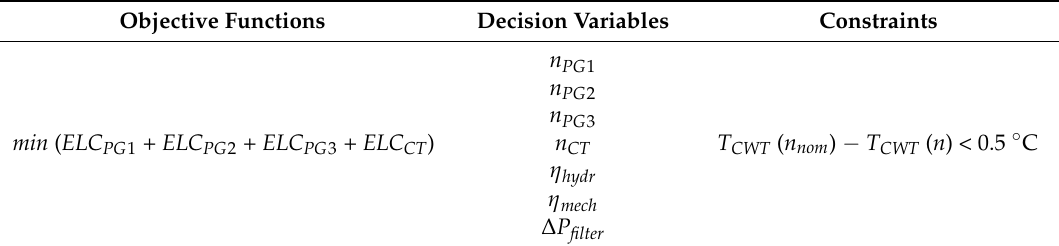
Table 7. Deviations obtained for the pumps measured